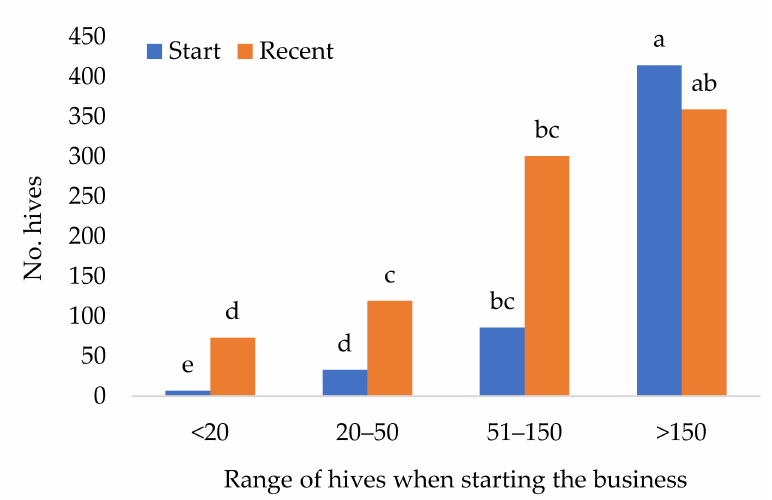
Figure 4. The change of hives numbers that are reared by beekeepers between the start of the beekeeping rearing and recent rearing (F 3, 478 = 19.030, p < 0.0001). Data were log-transformed before analysis to reach normal distribution. Bar with different letters is significantly different at p < 0.05 according to the Tukey